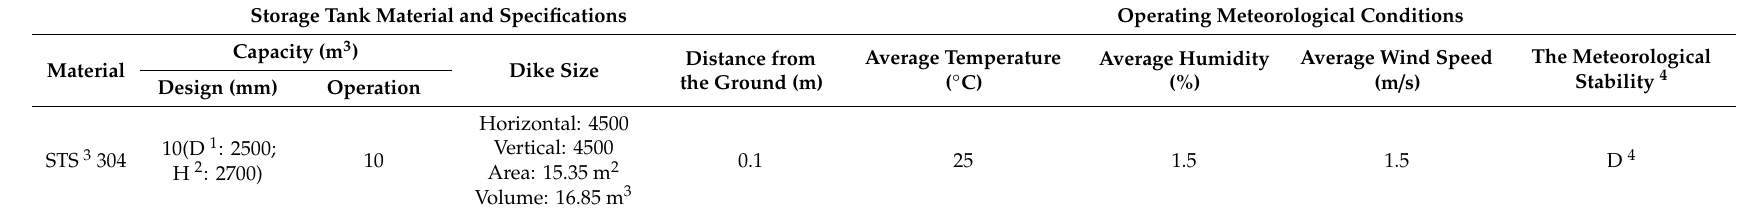
Table 3. Modeling conditions.